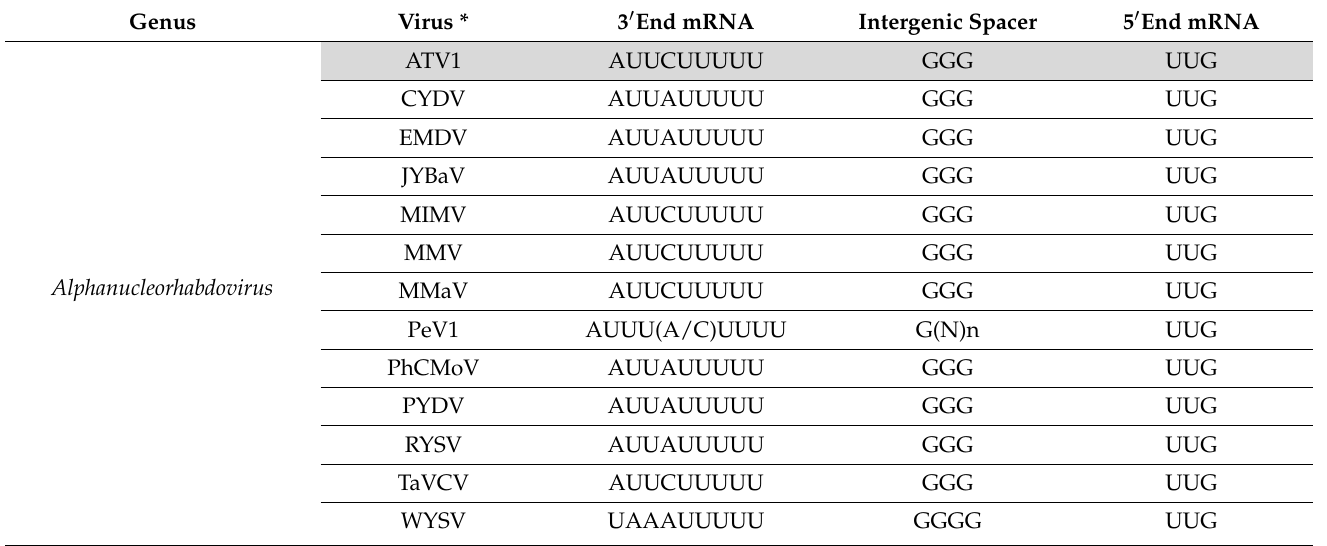
Table 2. Consensus plant rhabdovirus gene junction